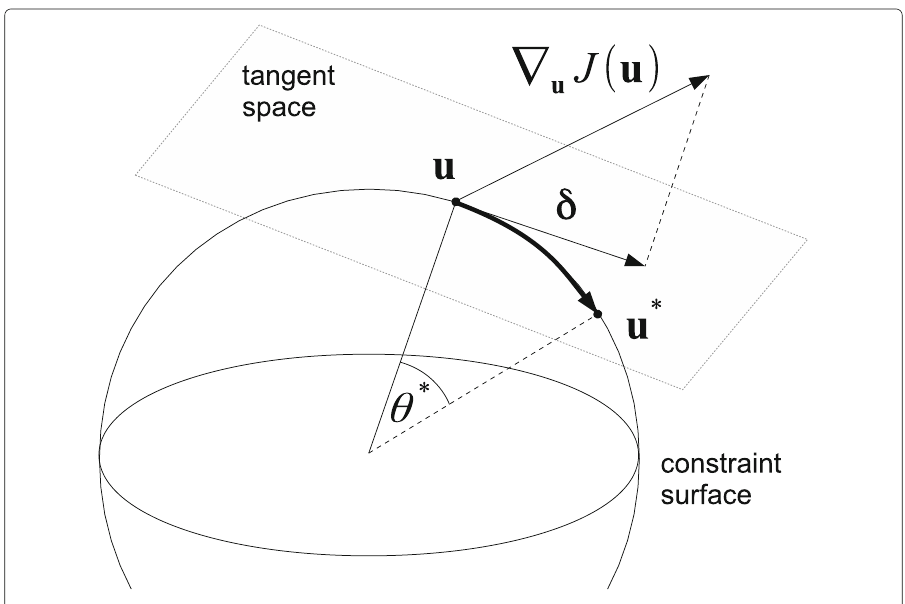
Fig. 1 Optimization using gradient method with L 2 -norm